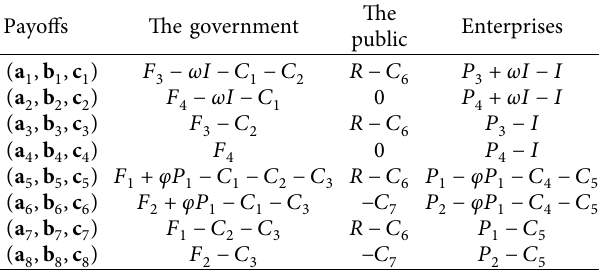
Table 3: The specific payoffs of government, public, and